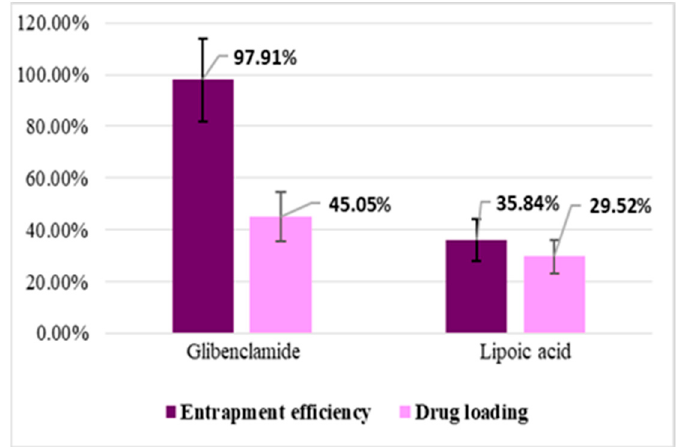
Figure 4. Entrapment efficiency (EE%) and drug loading (DL%) for CS–Gly and CS–LA systems.